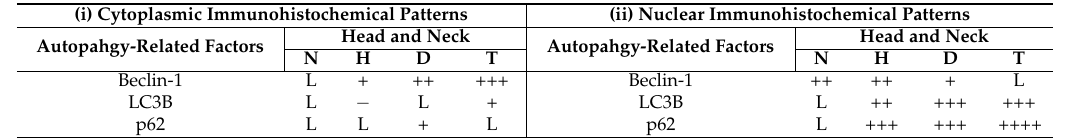
Table 1. ( i ) Cytoplasmic and ( ii ) nuclear immunohistochemical patterns of the triad Beclin-1/LC3B/p62 in each stage of head and neck